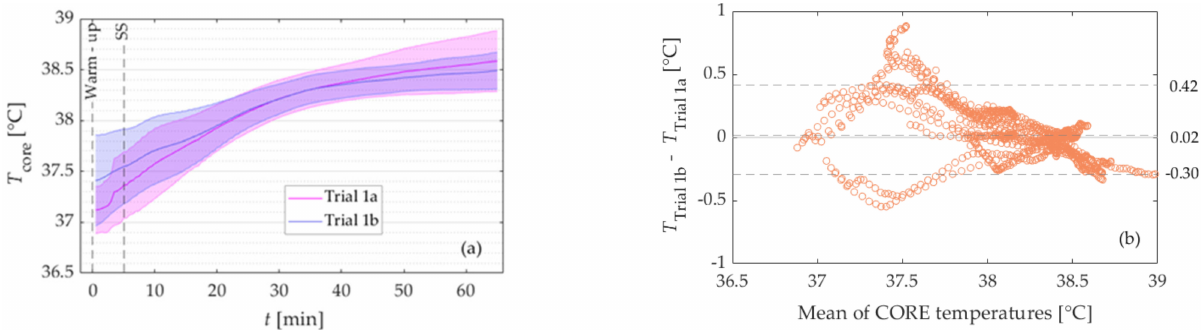
Figure 1. ( a ) Mean core body temperature as determined with the CORE sensor during Trial 1a (pink) and Trial 1b (violet) of Study I. The shaded areas represent the corresponding standard deviations. ( b ) Bland-Altman plot of the data in a). The dashed lines represent limits of agreement (LoA) and bias for the entire